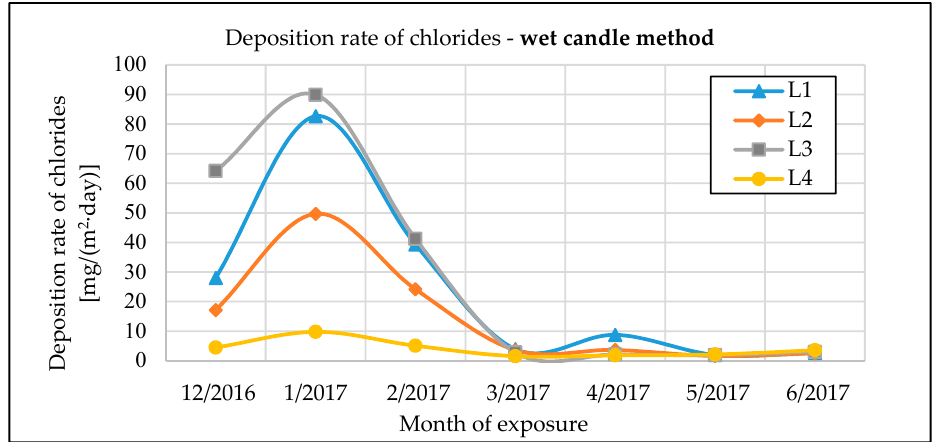
Figure 9. The deposition rates of chlorides determined by the wet candle method.